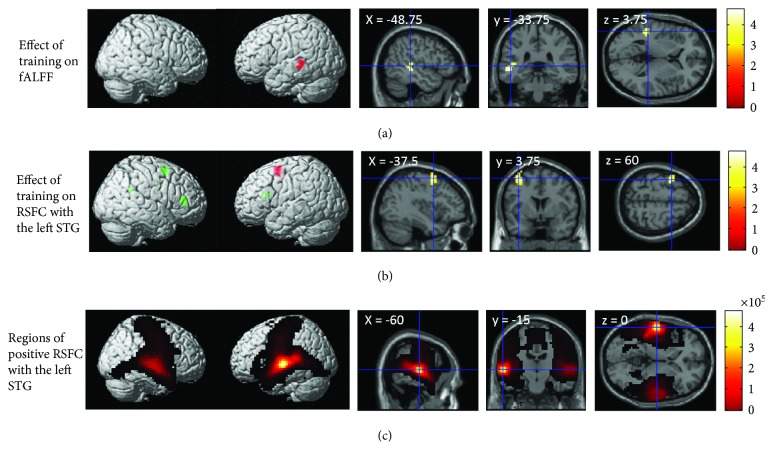
The effect of training with TCSSL on RS-fMRI measures. (a) The effect of training with TCSSL on fALFF. The results are shown with P < 0.05, corrected for multiple comparisons at cluster-level with an underlying voxel-level of P < 0.001, uncorrected. There was a larger increase in fALFF in the training with TCSSL group compared with the active control group (this analysis was performed to identify differences in pre- to posttraining changes between groups, as described in the Methods section). Compared with active control training, training with TCSSL resulted in an increase in fALFF in the left STG and the left middle temporal gyrus. (b) The effect of training with TCSSL on RSFC with the left STG. There was an increase in RSFC with the left STG in the training with TCSSL group compared with the active control group (red areas: P < 0.05, corrected for multiple comparisons at cluster-level with an underlying voxel-level of P < 0.001, uncorrected; green areas: P < 0.001, uncorrected). Compared with the active control training, the training with TCSSL resulted in a significant increase (red areas) in RSFC between the left STG and an anatomical cluster that spread around the left middle frontal and superior frontal premotor area (this analysis was performed to identify differences in pre- to posttraining changes between groups, as described in the Methods section) and tendencies of increase in RSFC with the left STG in bilateral frontal and right temporal areas. (c) Regions that showed positive RSFC with the left STG. The results shown were obtained using a threshold of threshold-free cluster enhancement (TFCE), P < 0.05 based on 5000 permutations.